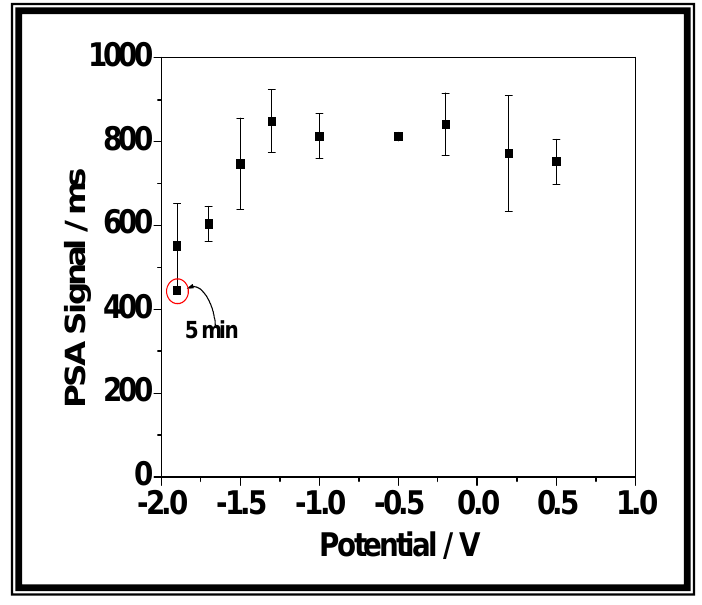
Figure 4. Chronopotentiometric guanine oxidation signal as a function of the desorption potential applied to the DNA immobilized layer. Conditions for DNA immobilization: 5.0 min at 0.200 V from a 5.00 ppm dsDNA solution. The “desorption potential” was applied for 2.0 min (with the exception to the point indicated in the plot as 5 min) under stirring in a 0.200 M acetate buffer solution pH 5.00. Stripping conditions: initial potential: 0.500 V; current: 8.0 µA; solution: 0.200 M acetate buffer pH